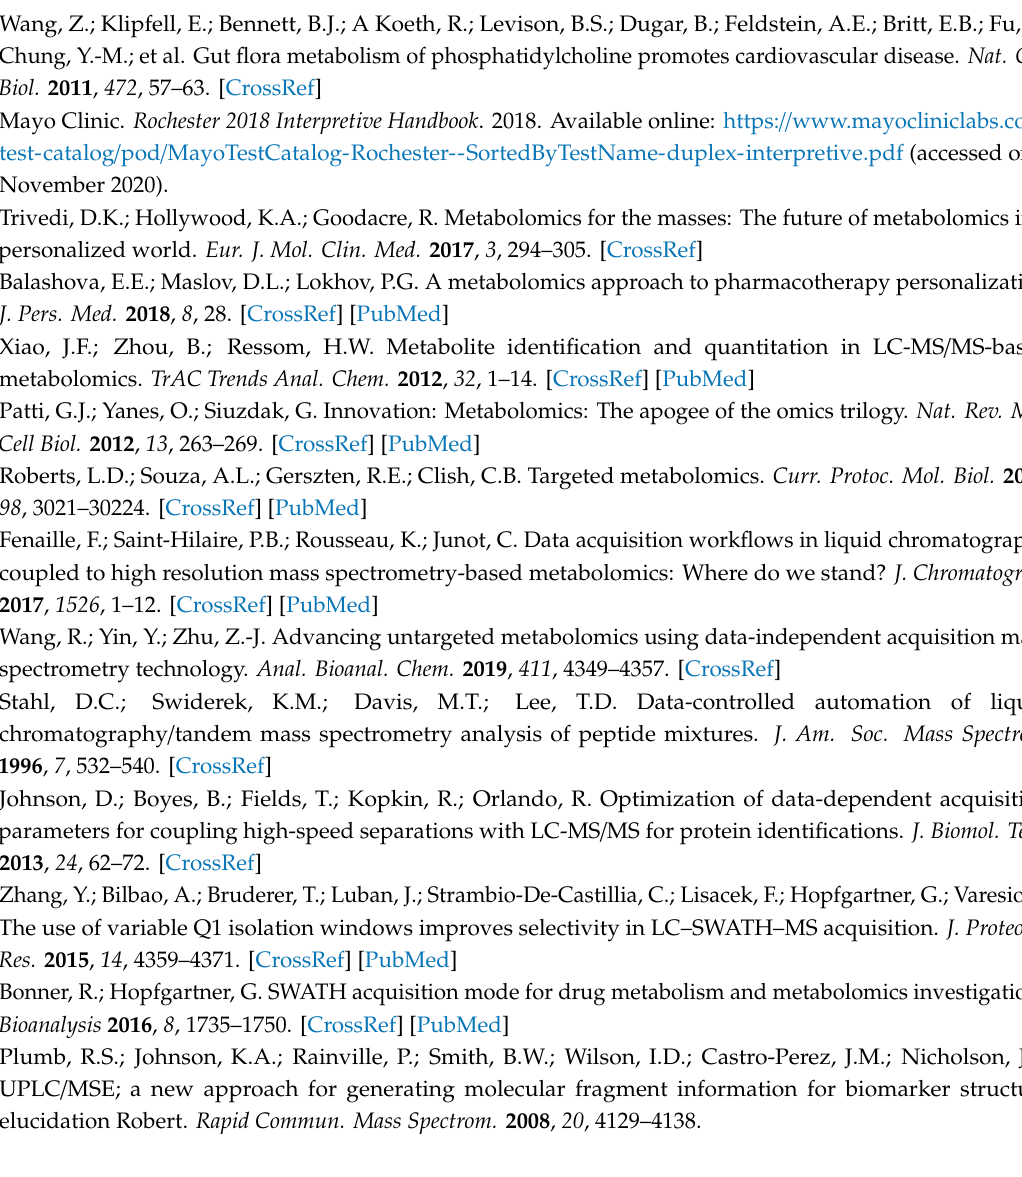
Figure S1: Variable window calculator results, Figure S2: The quantification values of 10 structural isomers in 10 volunteers, Figure S3: Product ions of the 10 structural isomers measured by a flow injection analysis and MRMHR, Table S1: Standards and internal standard correction, Table S2: Internal standards, Table S3: Clinical variables of ten healthy male subjects, Table S4: SWATH window sizes for the fractionation method, Table S5: SWATH windows sizes for the HILIC method, Table S6: The quantification accuracy of structural isomers, Table S7: Correlation and accuracy of the quantification values of structural isomers in 10